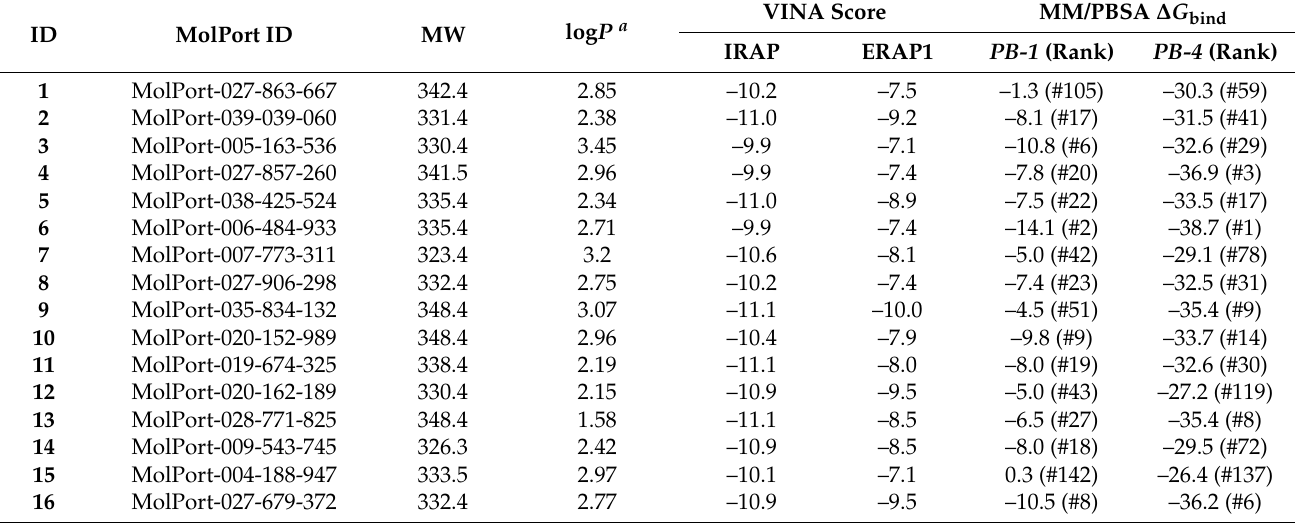
Figure 3. ( A ) Crystal structure of IRAP illustrating the position of targeted pocket and color-coded according to its functional domain I–IV. ( B ) Key residues that comprise the targeted pocket, color-coded according to IRAP domain. ( C , D ) Representative docked poses of two compounds, 5 and 26 , shown in yellow-C sticks. Hydrogen bonding interactions with key residues from domains II and IV of IRAP are indicated with dashed lines and the corresponding distance in Å. Table 1. The final set of 33 compounds obtained for experimental evaluation, indicating docking scores against IRAP and ERAP1, and estimated binding free energy obtained from MM/PBSA calculations using two parameter sets. Energies are in kcal/mol and ranking (#) is relative in each